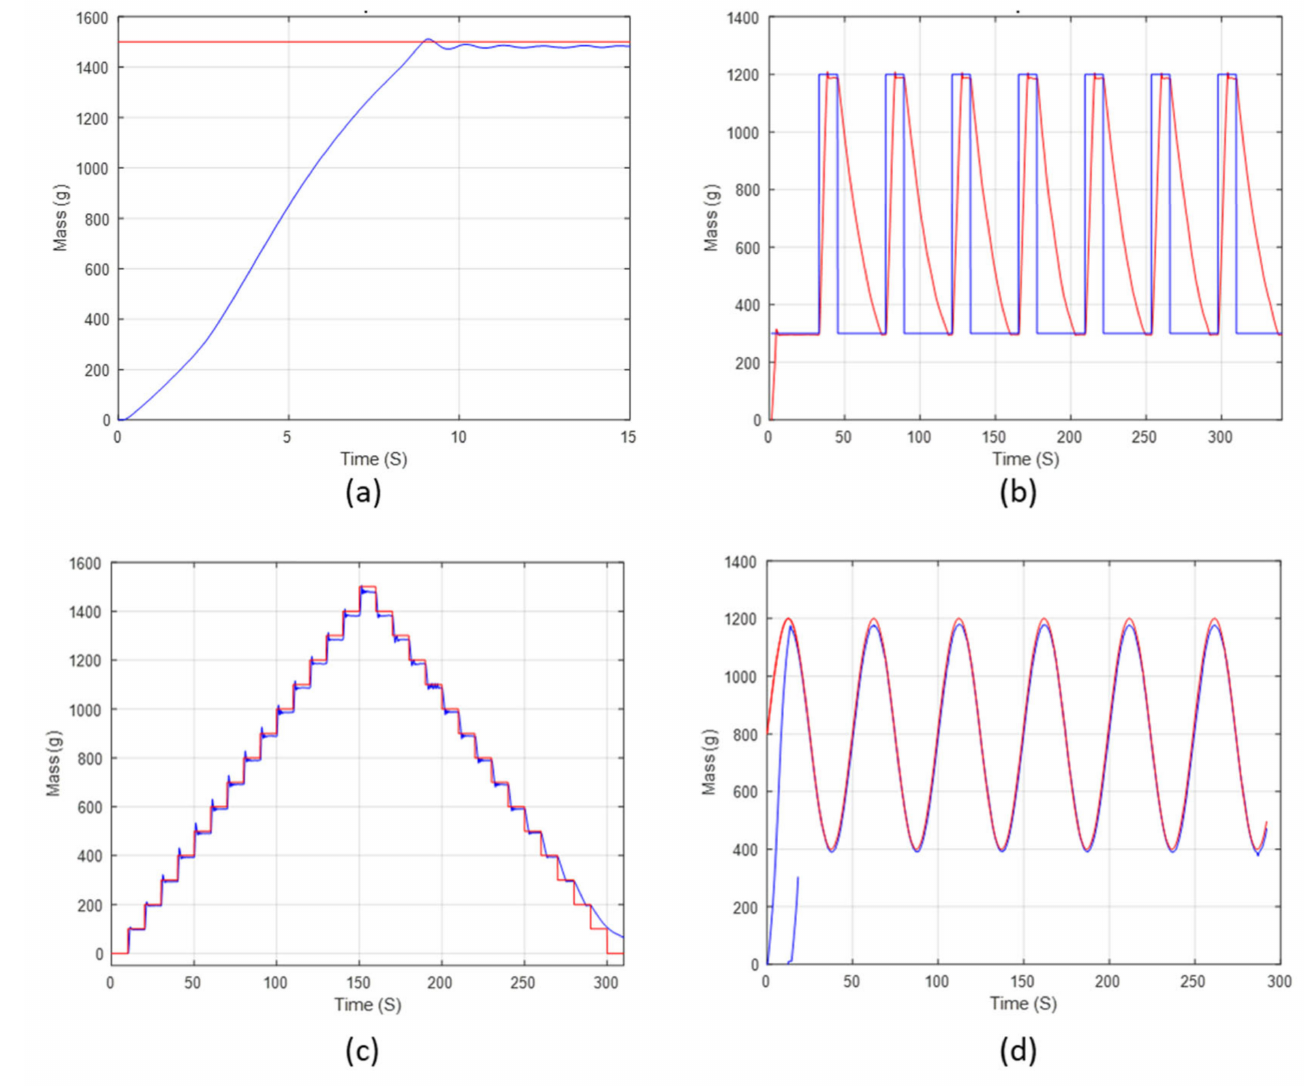
Figure 15. Gain scheduling PID controller’s Response to ( a ) step, ( b ) square-wave, ( c ) staircase, and ( d ) sinusoidal-wave command